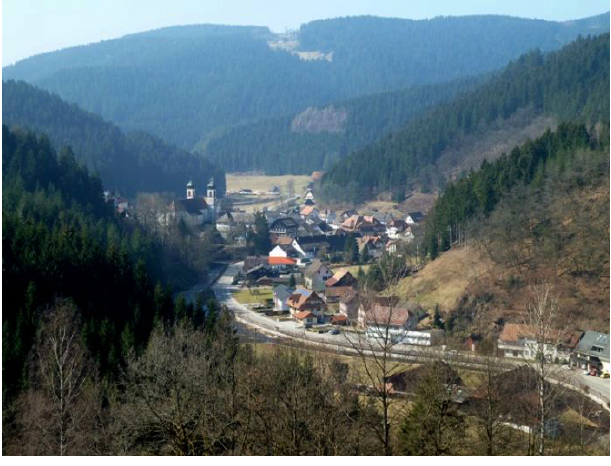
Fig. 4 . View of Schapbach in 2012 (photo: C.